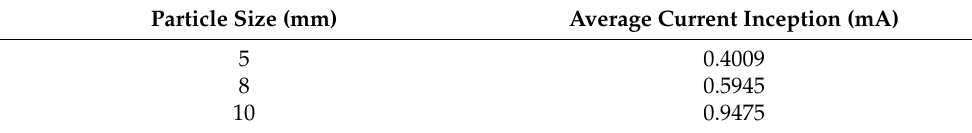
Table 5. The Average Value of Peak Corona Current at The Inception